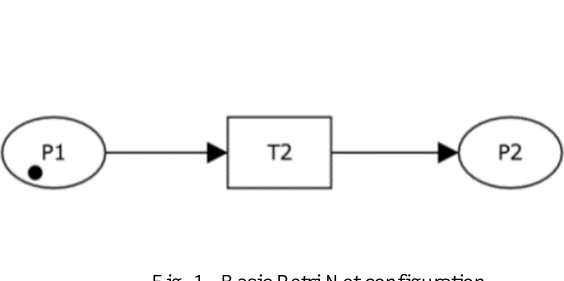
Fig. 1. Basic Petri Net